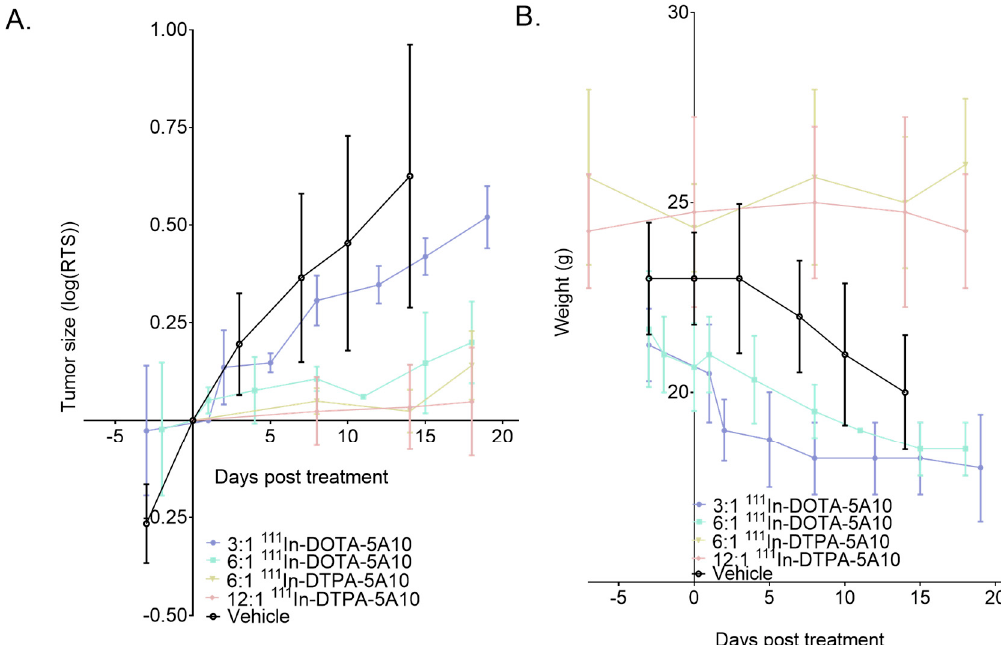
Figure 3. The therapy efficacy for 111 In-DOTA-hu5A10 and 111 In-DTPA-hu5A10 for chelate-to-antibody ratios of 3:1, 6:1, and 12:1. ( A ) Tumor size ratio (log(RTS)) and ( B ) weight change during therapy. It can be clearly seen that the therapy efficacy was highly dependent on the chelate-to-antibody molar ratio and